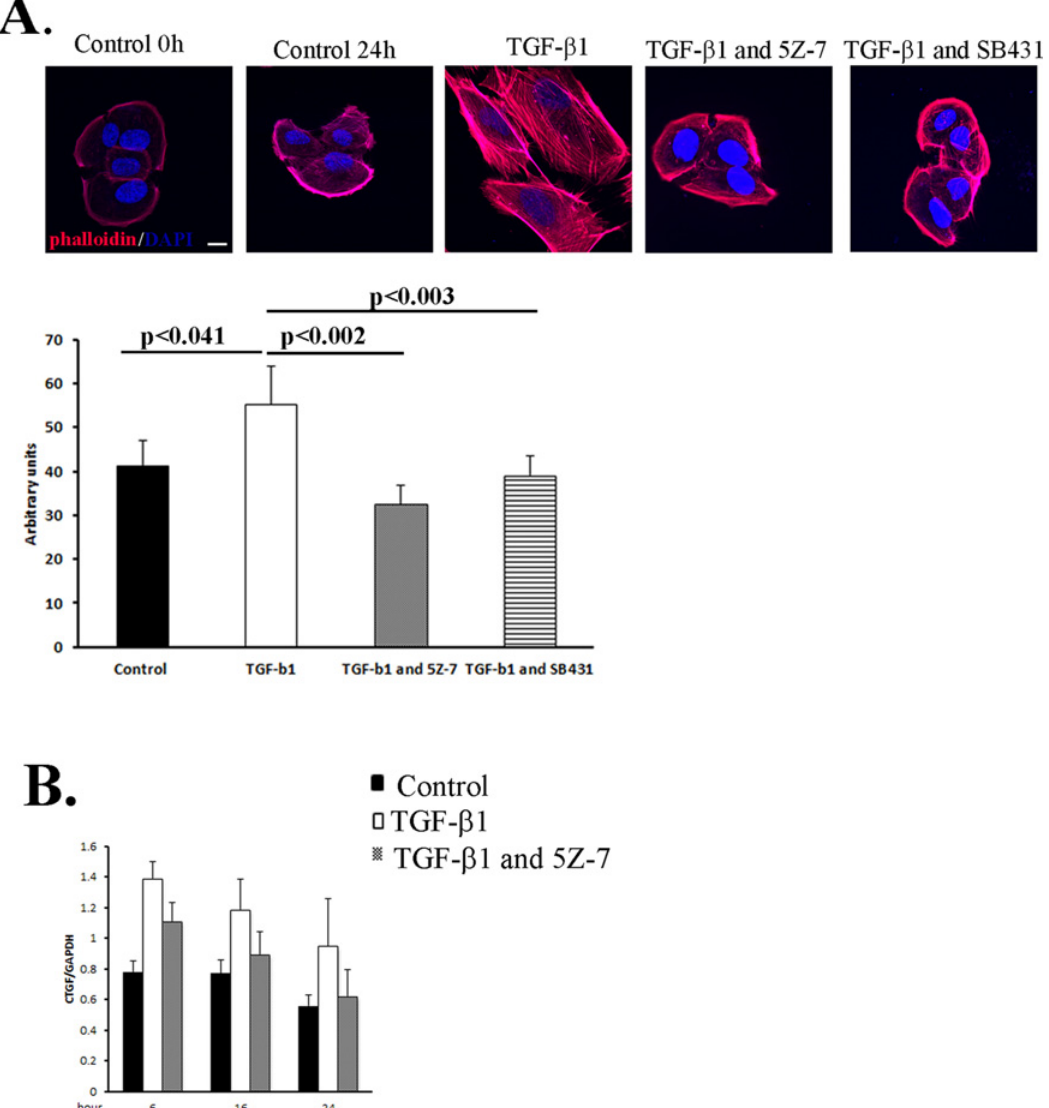
Fig 3. TGF- β regulates morphological and transcription changes in RPE cells through TAK1. A: RPE cells were plated on fibronectin-coated glass coverslips, serum-starved for 16 hours, pretreated with 5Z-7-oxozeaenol (1 μ M) or SB431542 (10 μ M), or DMSO for 1 hour, then treated with or without TGF- β 1 for 2 days. Following treatment the cells were stained with rhodamine-phalloidin (actin fibers-red) and DAPI (blue) and visualized by confocal microscopy. Scale bars: 20 μ M. The histogram represents quantification of cells size B: Serum-starved RPE cells pretreated with 5Z-7-oxozeaenol (1 μ M) DMSO for 1 hour, were exposed to TGF- β as in A. Total RNA was extracted at each time point and qPCR was performed. Transcription levels of CTGF were determined after 6h, 16h and 24h. Bars represent the specific mRNA amount relative to GAPDH mRNA in the same samples. All experiments were performed in triplicates. Representative histogram from two independent experiments. Statistics were computed using student t-test (Two tailed distribution equal variance). Data is expressed as the Mean ±